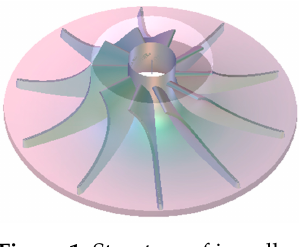
Figure 1. Structure of impeller. Table 1. Detailed geometric parameters of